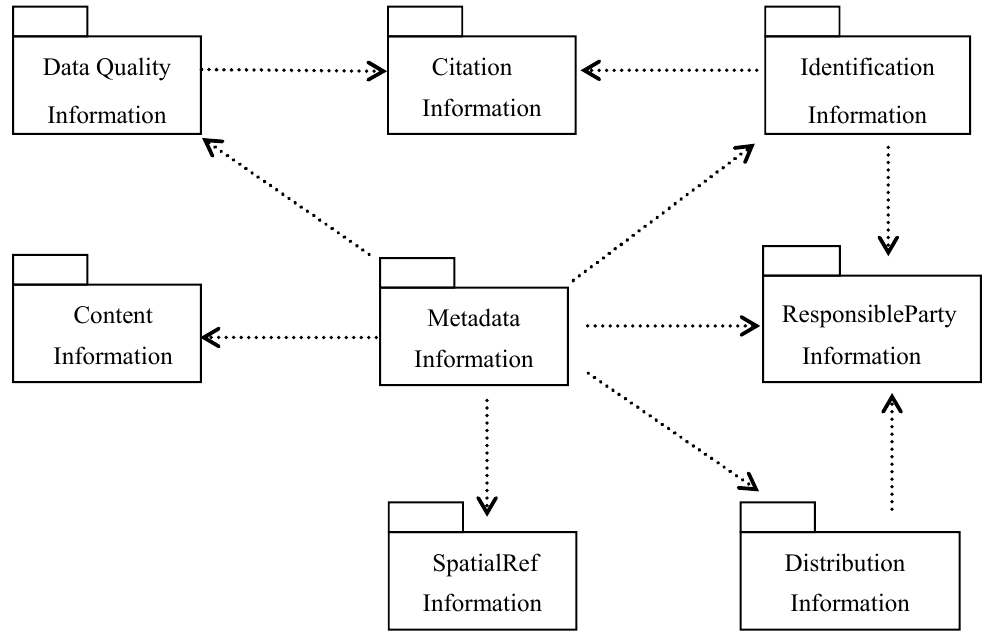
Figure 4. Multi-source remote sensing metadata concept structure diagram.